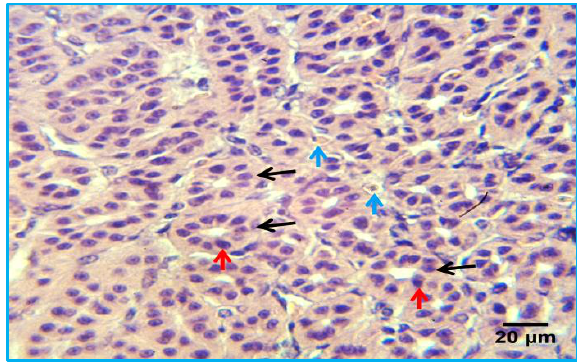
Figure, 7: Transverse section tubuloacinar glands shows secretory unites (Black arrows) and nucli of cuboidal cells (Red arrows), blood vessels. (H and E) stain.